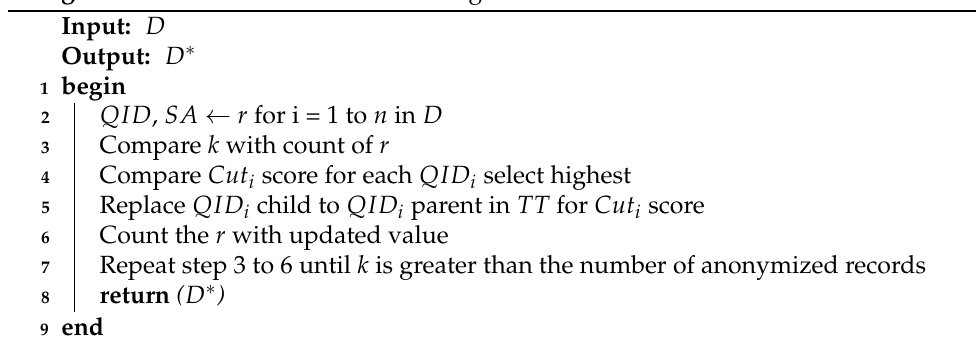
Algorithm 1: Subtree Generalization